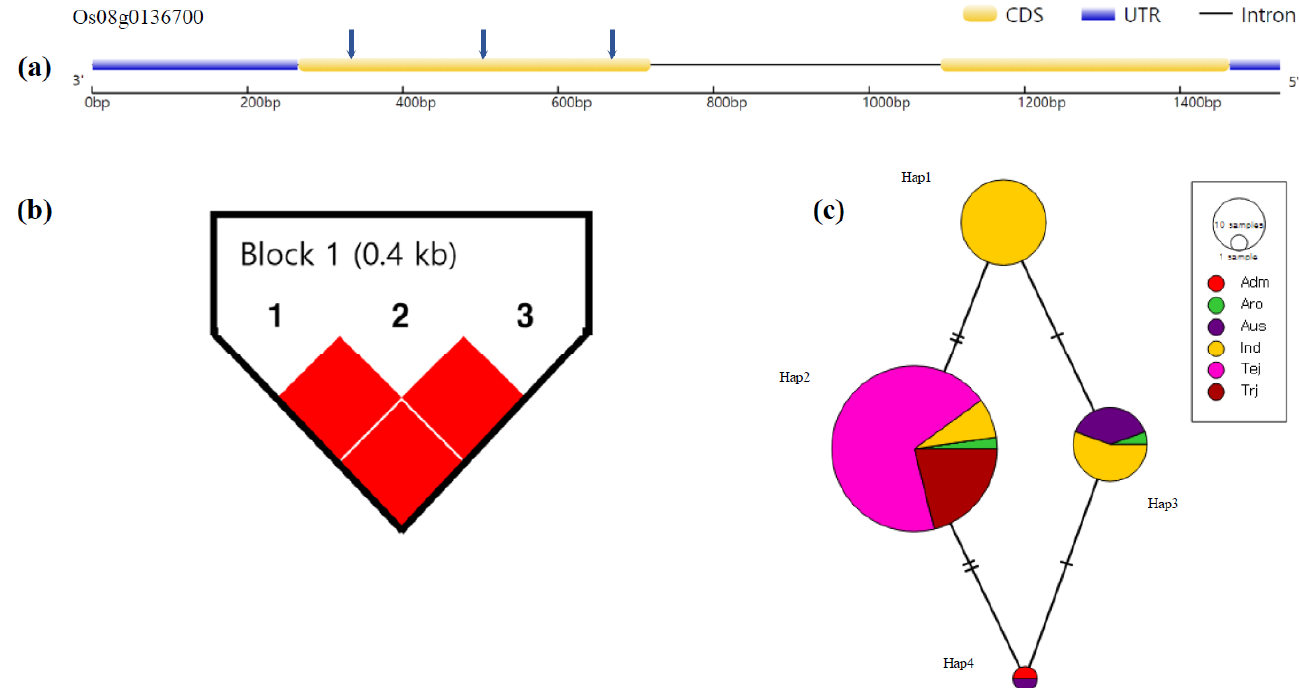
Figure 6. Haplotype analysis of Os08g0136700 . ( a ) Schematic representation of gene structure and SNPs positions in Os08g0136700 . Yellow, blue blocks and gray line represent exon, untranslated region (UTR) and intron regions, blue vertical bars represent SNPs. ( b ) Linkage disequilibrium (LD) analysis of SNPs in Os08g0136700 . D’ was used to indicate LD level, with LD blocks defined using the Confidence Intervals function in the analysis software. Red blocks indicate complete LD between each SNP. ( c ) Haplotype variation analysis. Colors indicate rice subspecies as indicated in the legend. Circle size indicates the number of varieties in each Hap. Traverse lines represent the extent of variation between four haplotypes. Table 4. Results of haplotype analysis of Os08g0136700 .